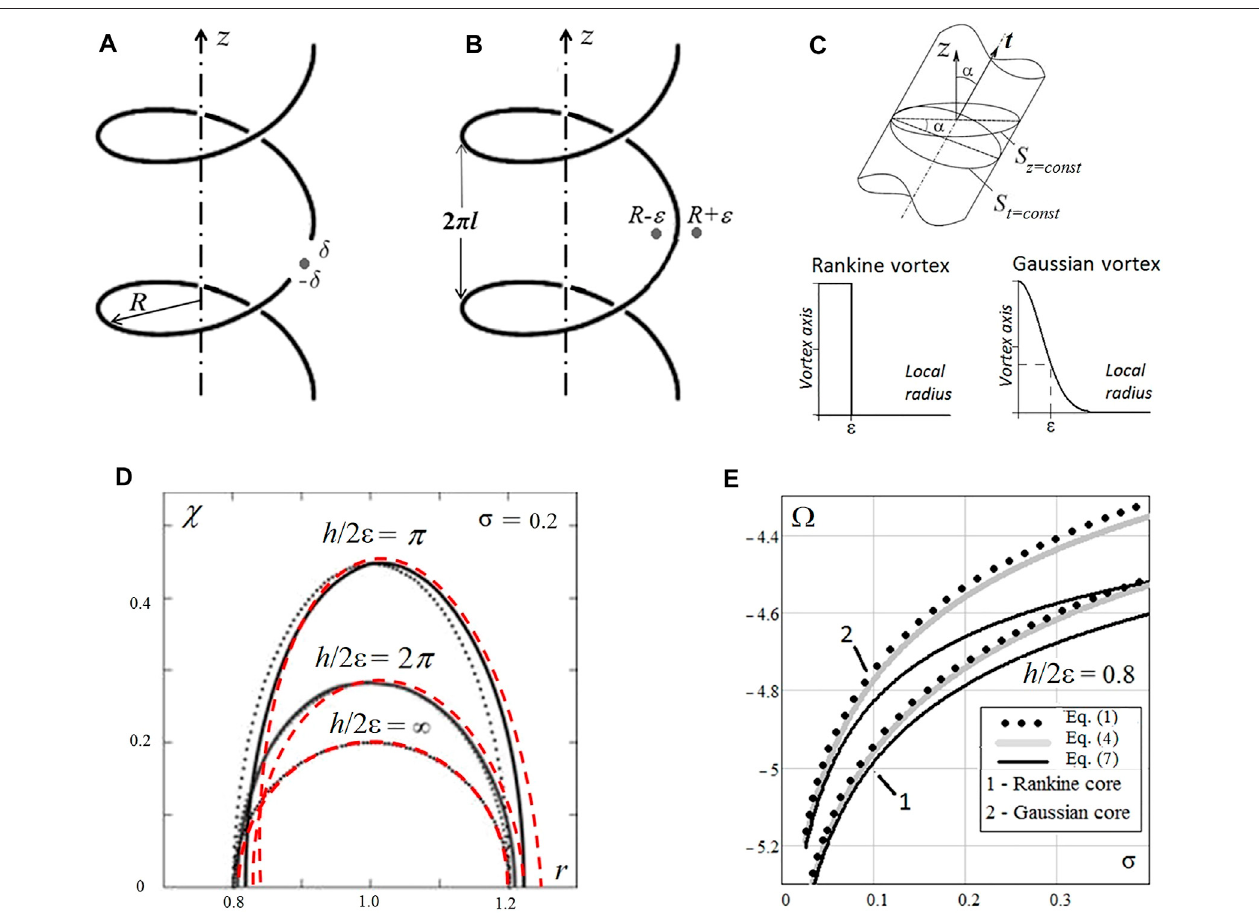
FIGURE1| Sketchoftheregularizationof fi lamentapproximationsinthedevelopmentofthemotionofahelicalvortexby (A) thecutoffmethodand (B) themethod ofaveragingthevelocityinthevicinityofthesingular fi lament; (C) RankineandGaussianvorticityofthe fi nitevortexcore. (D) Examplesinthehelicalvariable( r, χ =z+r θ /l ) at S t with different vortex pitches h /2 ε = π ; 2 π ; ∞ for the cross-sections of the vortex tubes of the touching vortex ring (dotted lines) in the fi rst two methods and deformations of helical vortex tube in Dyson technique with Rankine (solid lines) and Gaussian distributions (dashed red lines). (E) Angular velocity of the helical vortex versus the size of its vortex core σ = ε / R , obtained using Eqs 1 , 4 , 7 with Rankine vortex distributions (curves 1) and Gaussian vortex distributions (curves 2).